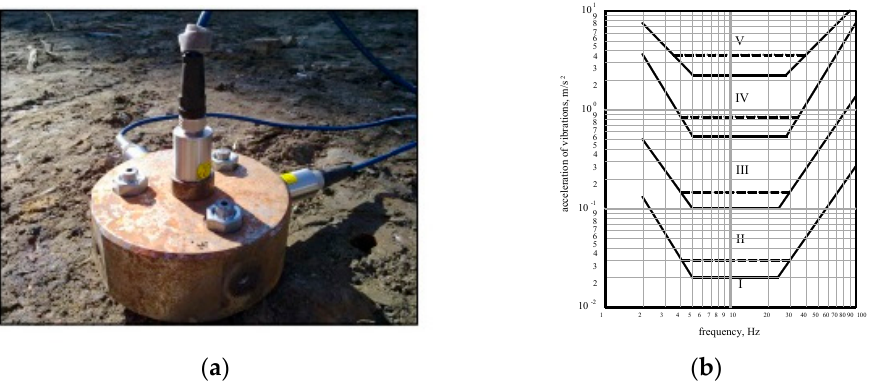
Figure 3. ( a ) Sensor for acceleration measurements. ( b ) An exemplary scale for assessing the impact of vibrations on the structure of buildings (according to the Polish standard).